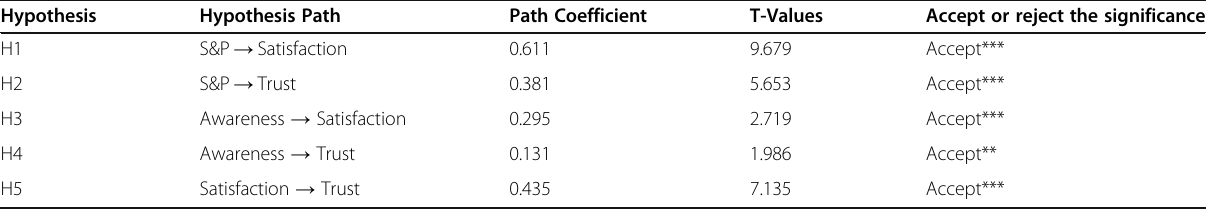
Table 5 Result of hypothesis tests based on PLS-SEM based model